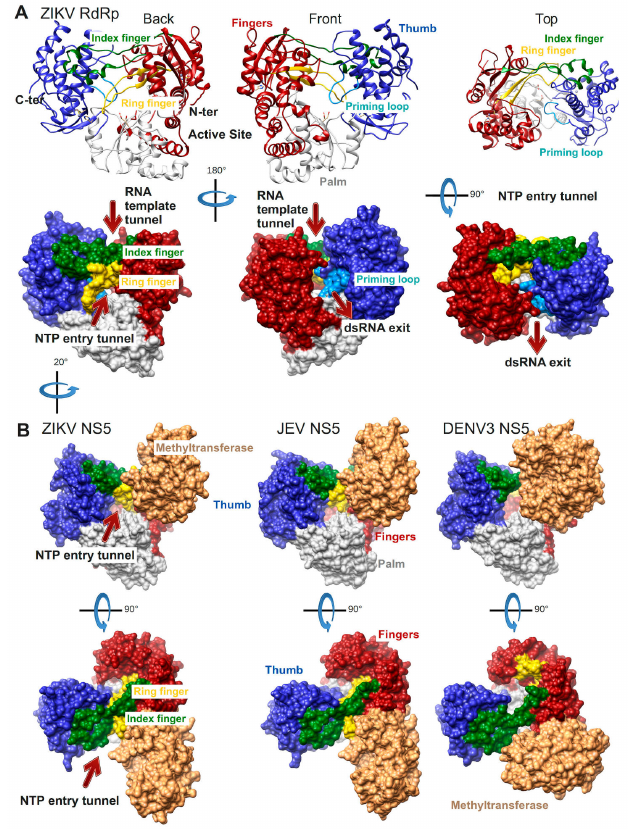
Figure 3. Flavivirus RdRp structures. ( A ) Structure of the ZIKV RdRp domain (PDB ID: 5U0C) in ribbon representations above and surface representations below. Back, front, and top views are shown. Important structural and functional features are colored (palm subdomain, gray; fingers subdomain, dark red (index finger, dark green and ring finger, gold); thumb subdomain, medium blue (priming loop, light blue)) and/or labeled. The side chains of the active site residues D335 (motif A) and D666 (motif C) are shown in sticks. ( B ) Structures of ZIKV full-length NS5 (PDB ID: 5U0B), JEV NS5 (PDB ID: 4K6M), and DENV3 NS5 (PDB ID: 4V0Q) containing the RdRp and methyltransferase (MTase in light brown) domains in surface representation using the same color code as in ( A ). Back views are rotated by ca. 20 ◦ to the right in relation to the representation in ( A ) in order to show the NTP entry, which is partially obstructed by the MTase